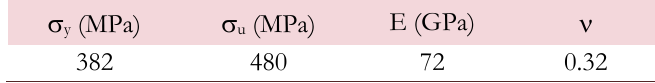
Table 1: Mechanical properties of the AW-2017A-T4 aluminum alloy.